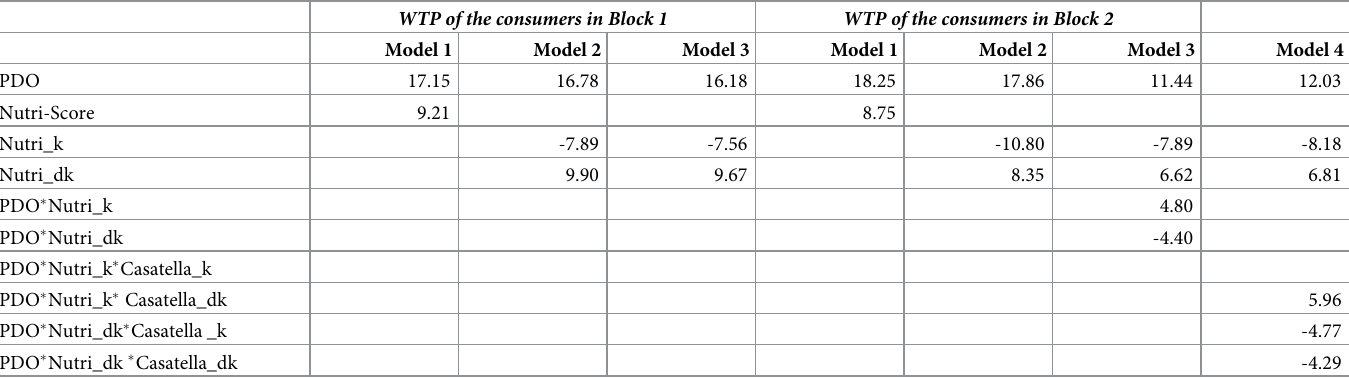
Table 7. Marginal Willingness To Pay (WTP) for CE attributes ( € /300 g of